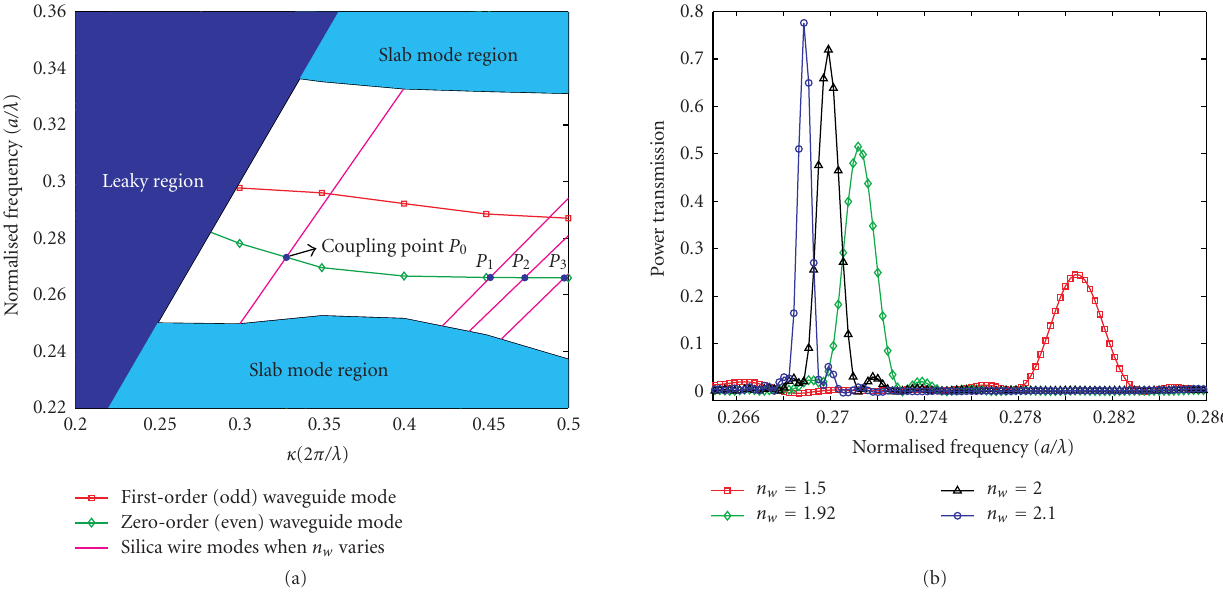
Figure 3: (a) The coupling points shift when the refractive index ( n w ) of SiO 2 -Wr varies from 1.5 ( P 0 ) to 1.92 ( P 1 ), 2.0 ( P 2 ), and 2.1 ( P 3 ). (b) The transmission comparison. As the coupling point moves to the flat band region, the coupling e ffi ciency goes up while the bandwidth shrinks. Table 1: Comparison of PCSW 0 − 3